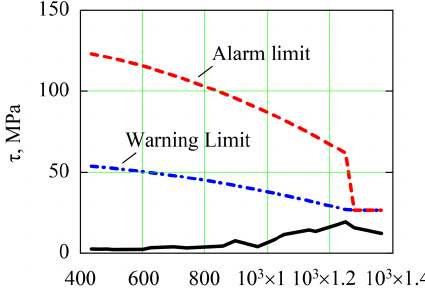
Fig. 5. Tangential stress τ depending on the engine speed